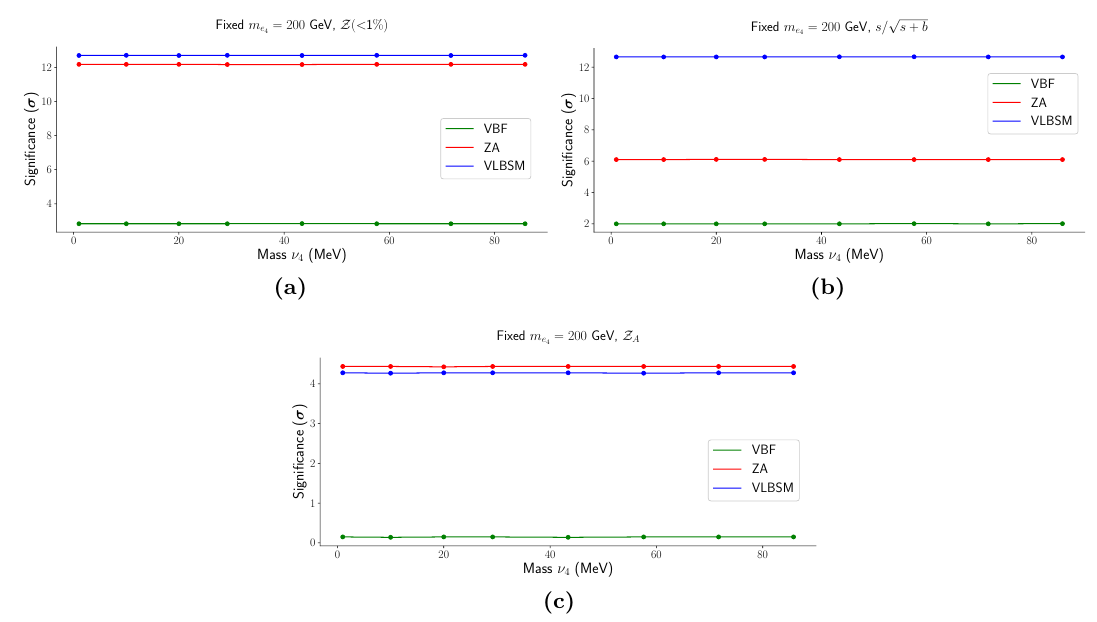
Figure 13. Significance as a function of the neutrino’s mass for a luminosity of L = 3000 fb − 1